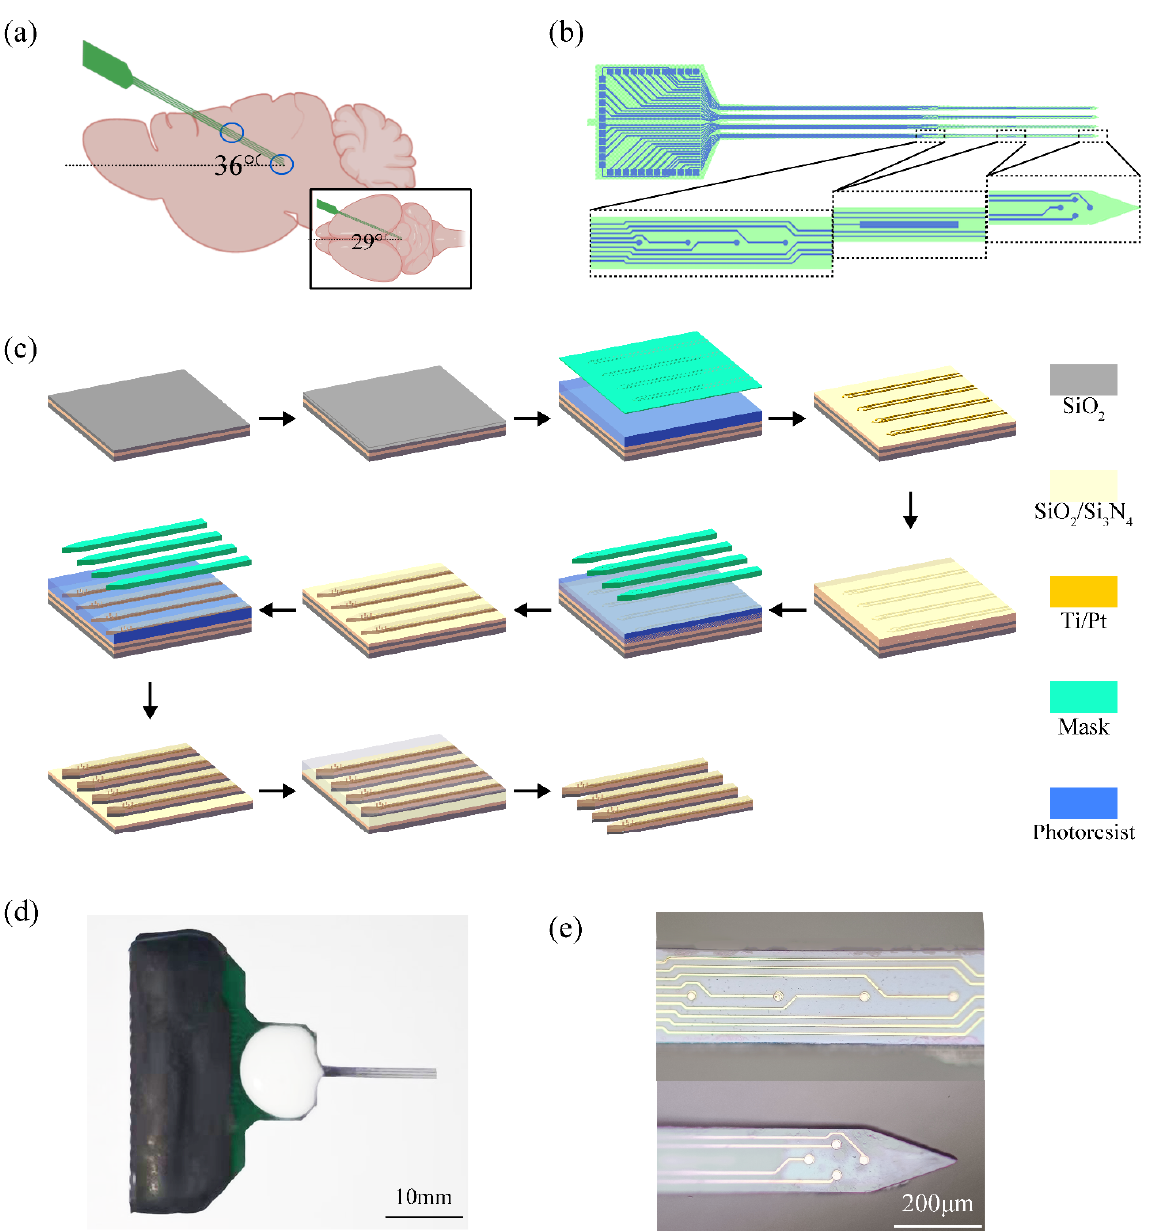
Figure 2. MEA design and fabrication. ( a ) MEA implantation path diagram in the sagittal plane. The blue circles are the location of the hippocampus and dorsal raphe nucleus. The smaller picture shows the MEA implantation path in the horizontal plane; ( b ) Site distribution map of the MEA; ( c ) The fabrication processes of the MEA. The processes are SOI wafer, thermal oxidation, photolithography, sputtering and stripping, plasma chemical vapor deposition, photolithography, oxygen plasma etching, photolithography, deep etching, black glue coating, and electrode release; ( d ) MEA finished product drawing, and ( e ) optical image of the MEA site. The upper image shows the site of the hippocampus, and the lower image shows the site of the dorsal raphe nucleus.